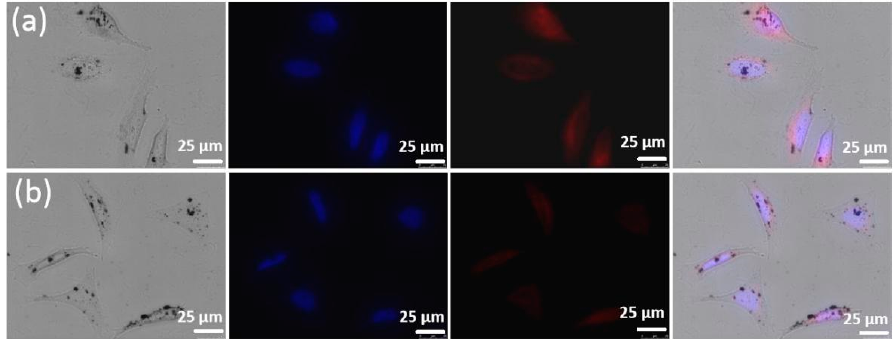
Figure 3. Intracellular uptake of ( a ) Au@MPA-PEG-HA-ADH-Dox (150 μ g/mL) and ( b ) Au@MPA-PEG-HA-Dox (150 μ g/mL) in HepG2 for 6 h.